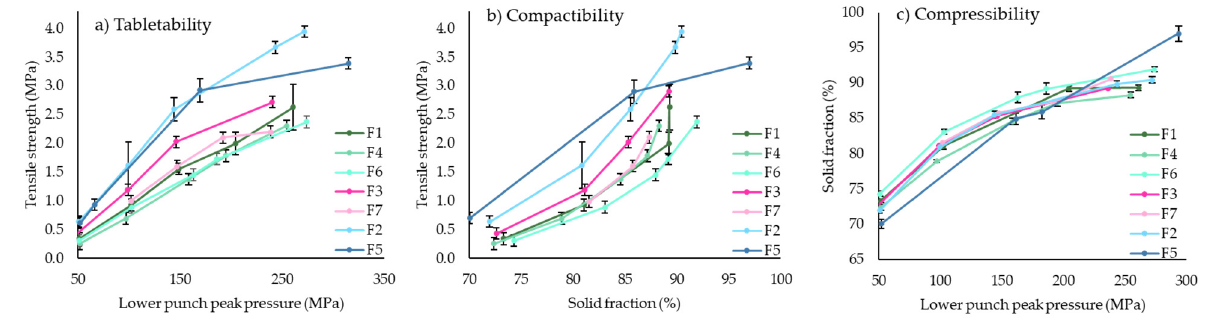
Figure 9. USP 1062 plots: ( a ) tabletability, ( b ) compactibility and ( c ) compressibility profiles of all round tablets ( n =